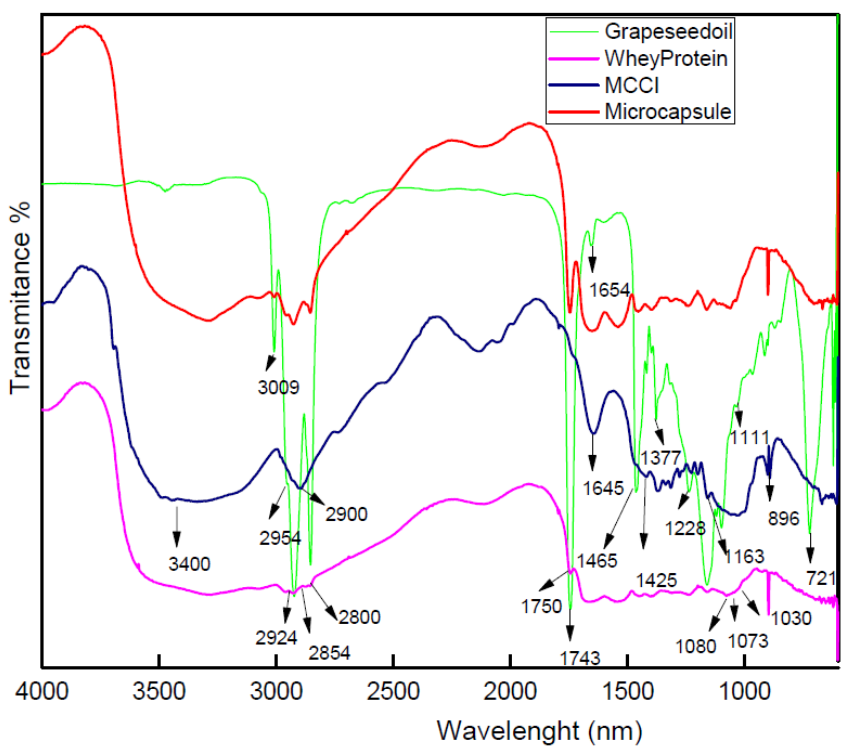
Figure 1. FTIR spectra of samples of WPI, MCC, grapeseed oil, and microcapsules in the wavenumber range of 4000–400 cm − 1 .